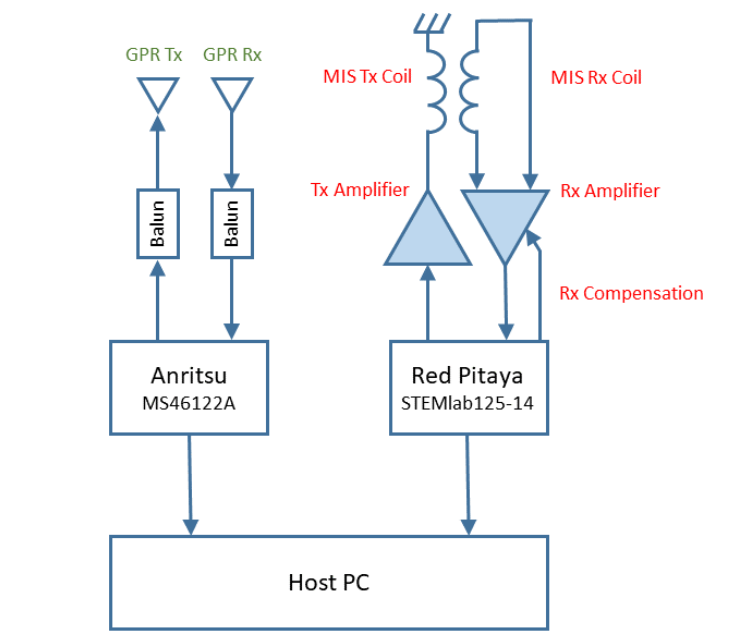
Figure 8. Schematic of combined MIS/GPR